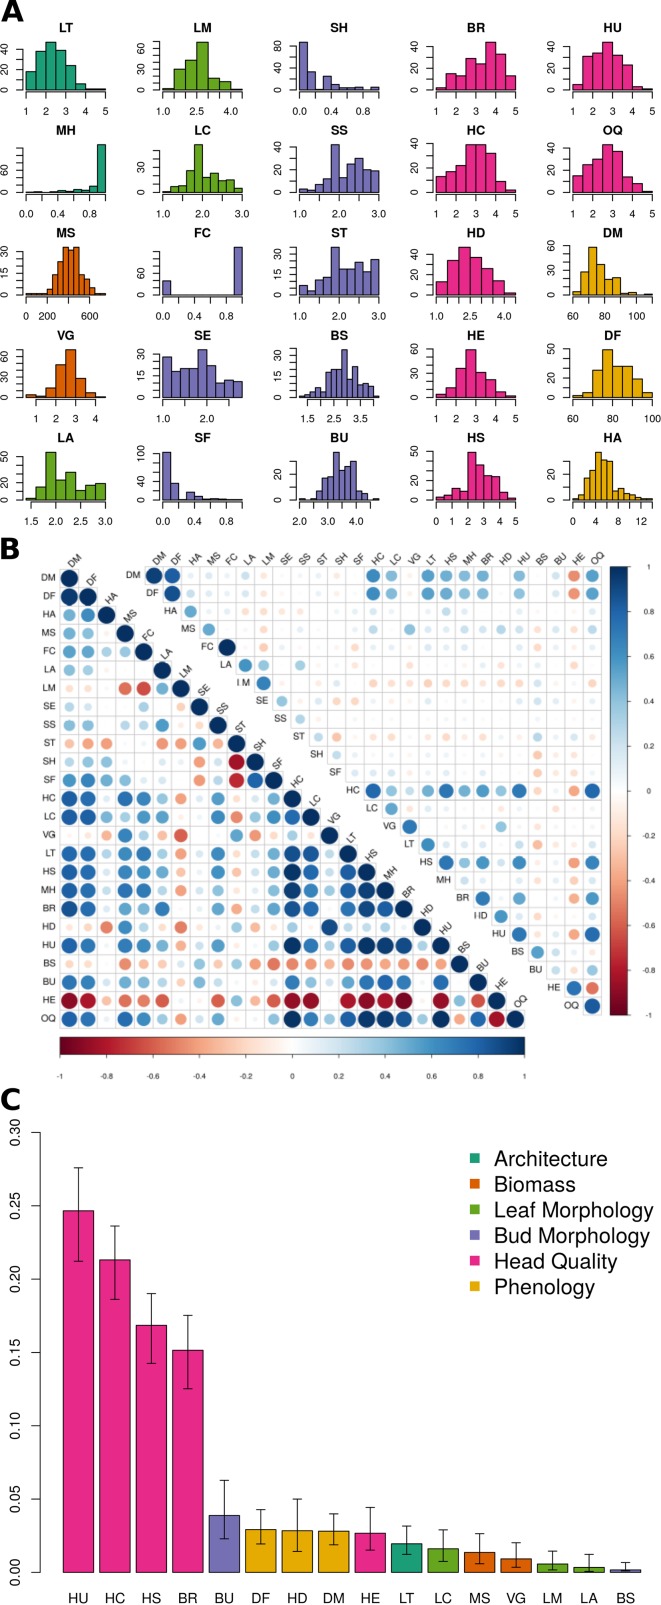
BolTBDH phenotypic analysis: (A) Distribution of phenotypic traits evaluated in year 1 and year 2 (Y12) trials. Trait class is indicated by color (architecture = dark green, biomass = orange, leaf morphology = light green, bud morphology = light blue, heading quality = pink, and phenology = yellow). (B) Y12 between-trait (bottom left) and between-year Y1 vs. Y2 (top right) Spearman correlation coefficients, with negative and positive correlations plotted in red and blue. (C) Percentage of Y12 overall quality model explained by relative importance predictors (RIA) by fitting the model [OQ ∼ LT + MH + MS + VG + LA + LM + LC + BS + BU + BR + HC + HD + HE + HS + HU + DF + DM] using the lmg method with the rateRvaR function raterimp() with 95% confidence intervals estimated by 1,000 permutations.